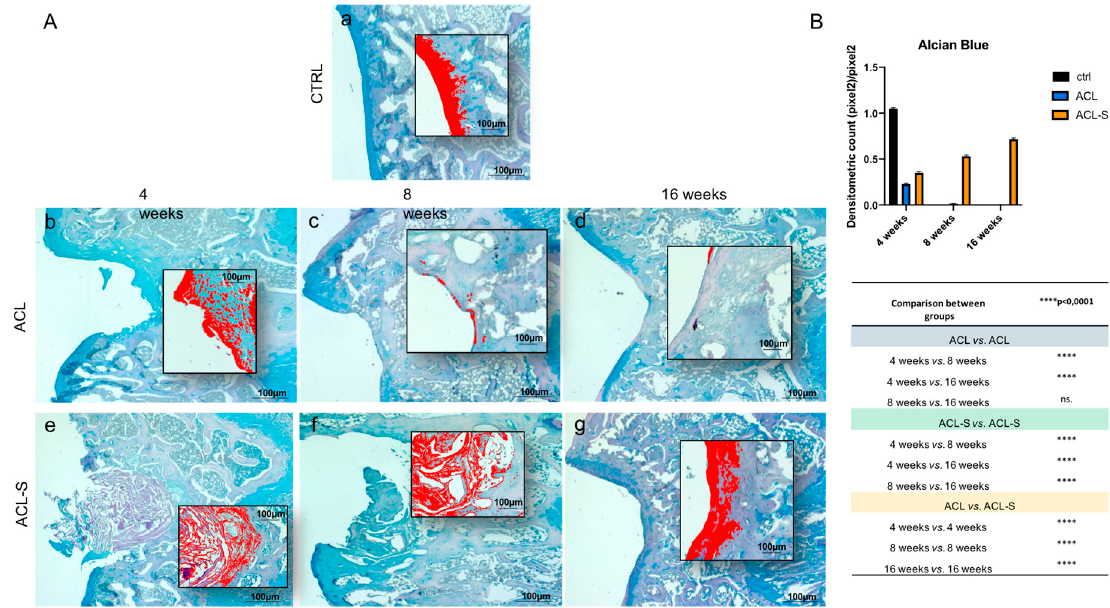
Figure 3. Histochemical evaluation of the deposition of sGAGs in femoral articular cartilage samples at 4-, 8- and 16-weeks post-surgery revealed by the intensity of Alcian Blue staining through computerised densitometric measurements and image analysis. ( A ) The inserts represent the image magnifications (scale bar: 100 μ m) analysed by the software: the red colour corresponds to high intensity Alcian Blue staining. ( a ) control sample of articular cartilage; ( b–d ) ACL group samples at 4-, 8- and 16-weeks; ( e–g ) ACL-S group samples at 4-, 8- and 16-weeks. Scale bars: 100 μ m. ( B ) Graph representing staining level expressed as densitometric count (pixel 2 ) normalized to the area of each section expressed in pixel 2 . Results are presented as the mean ± SD. Two-way ANOVA test followed by Tukey’s multiple comparison test reported that all pairwise comparisons were significantly different ( p -value < 0.0001) except for ACL 8-weeks vs. ACL 16-weeks, which was not significant (ns.).